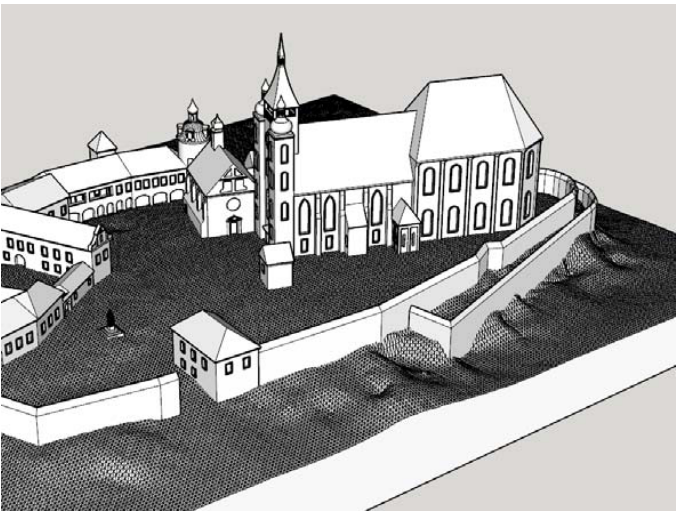
Figure 5. The original state of the 3D model before any modifications (e.g., adding the conductive part) were